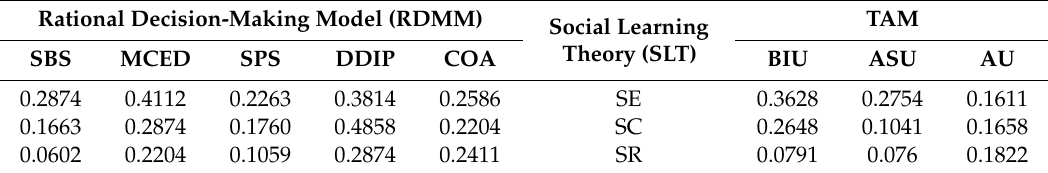
Table 5. The related factor-loading of the entropy method (EM)